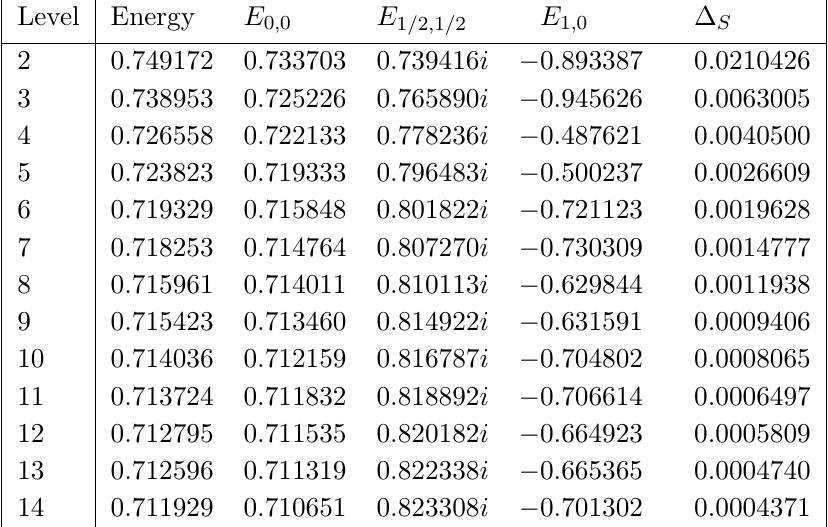
Table 2 . Independent observables of a solution describing 0-brane with θ = π with J = 1 boundary conditions. We provide data up to level 14, higher level data can be obtained 2 through the duality to the Ising model. Extrapolations of these quantities and their expected values are shown in table 3.